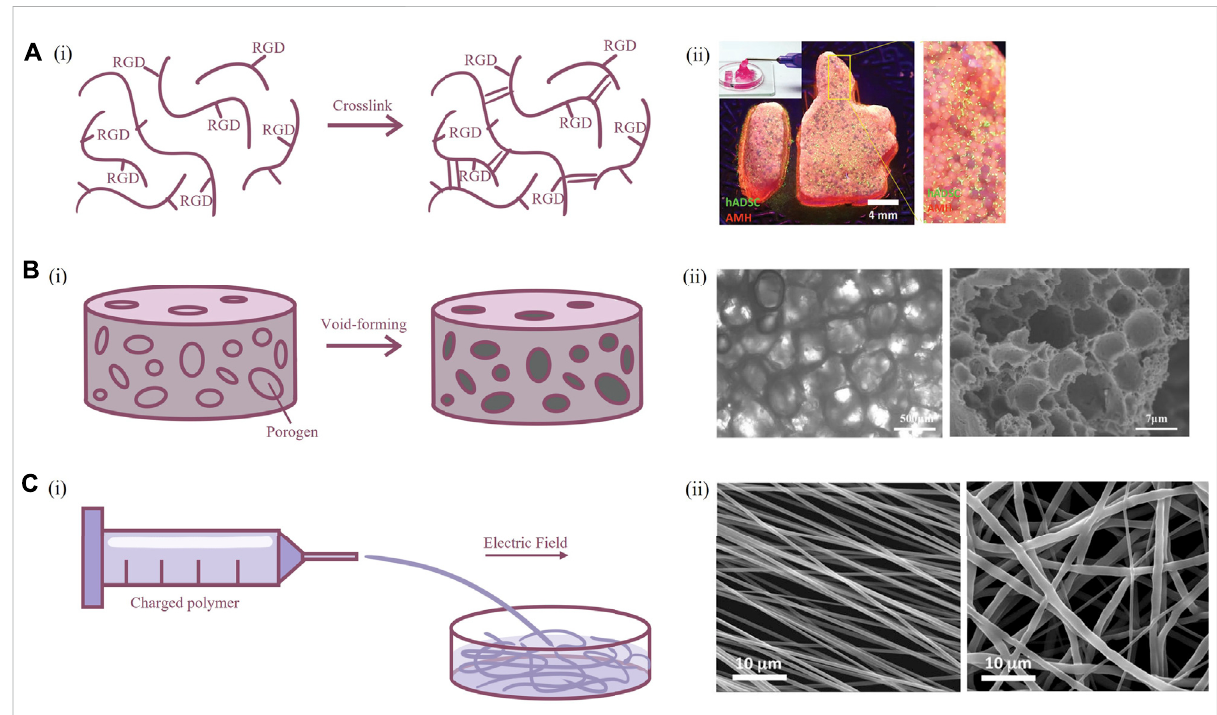
FIGURE 2 Fabrication techniques of scaffold for primary neuron culture. (A) Hydrogel scaffolds. [(A), i] Schematic illustration of crosslinking of modi fi ed polymers. [(A), ii] Image of hydrogel scaffold (Hsu et al., 2019). (B) Porous scaffolds. [(B), i] Schematic illustration of porogen emulsion and phase separation. [(B),ii] Bright- fi eldmicroscopeandscanningelectronmicroscopyimageofporousscaffold(Zhuetal.,2020). (C) Fibrousscaffolds. [(C),i] Schematic illustration of electrospinning. [(C), ii] Scanning electron microscopy of scaffold formed by aligned and random electrospun fi bers (Amores de Sousa et al.,